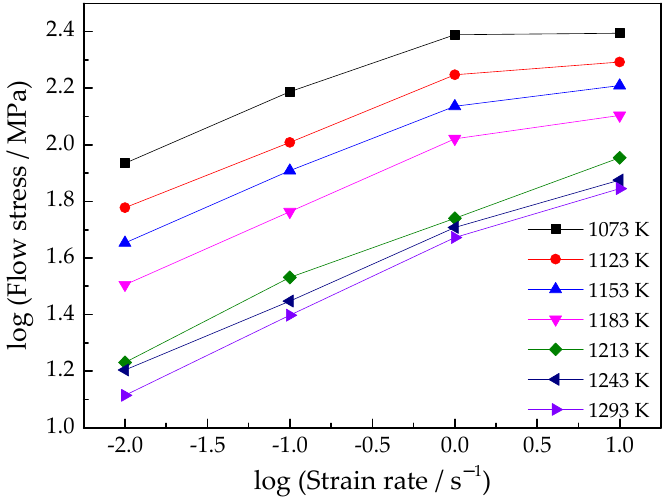
Figure 11. Relationship between log(strain rate) and log(flow stress).